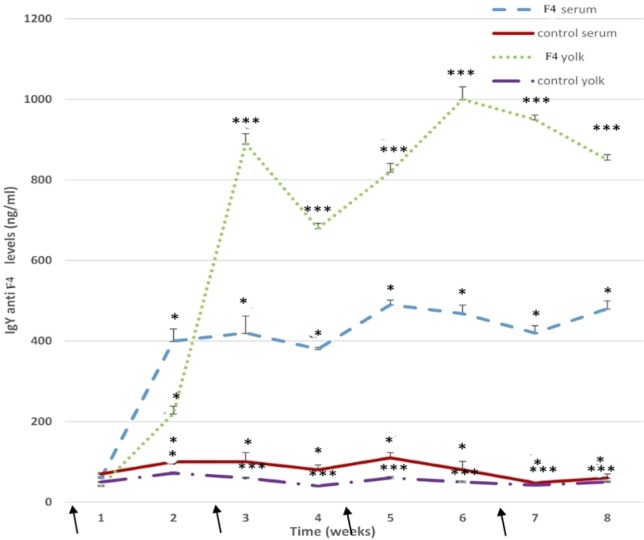
Anti-Escherichia coli F4-immunoglobulin levels. Serum and yolk levels of anti-E. coli F4-IgY in the F4 and Control groups from 23 to 42 weeks *P < 0.05, ***P < 0.001. Arrows indicate immunizations.